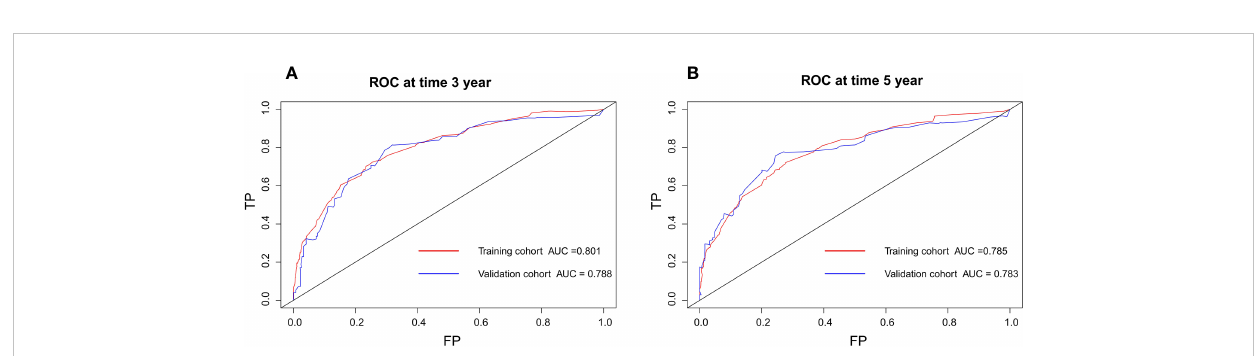
FIGURE 5 Discriminatory accuracy for predicting OS examined by ROC analysis calculating AUC. There-year OS in the training and validation I sets (A) . Five- year OS in the training and validation I sets (B) .